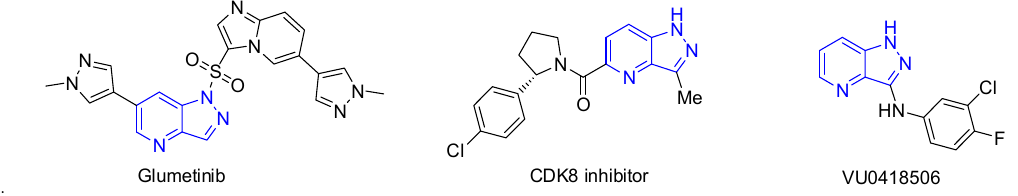
Figure 1. Biologically active pyrazolo [4,3- b ]pyridines.